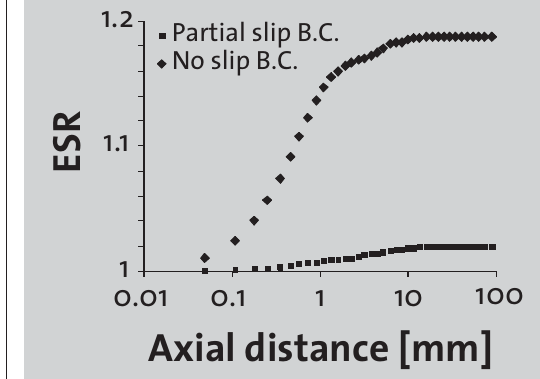
Figure 12: ESR comparison between no-slip and partial slip boundary condition at the die